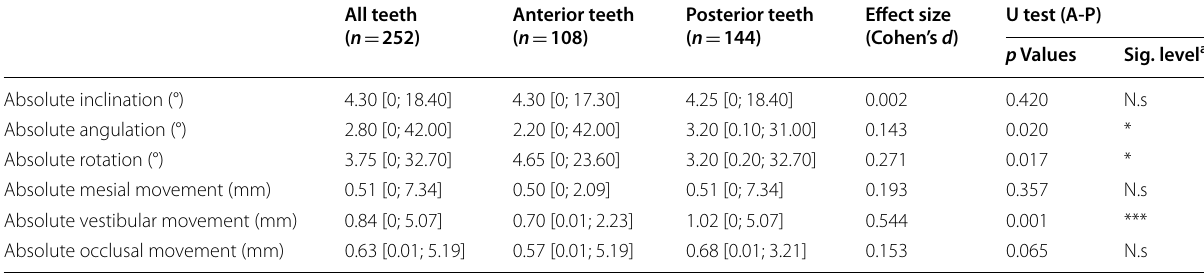
Absolute values of discrepancies (median [min; max]) of the dental arch for all teeth and for both frontal and posterior teeth separately and their effect size (Cohen’s d ) were reported. Given are inclination, angulation, rotation, mesial (sagittal) position, vestibular (transversal) position and occlusal (vertical) position. Mann–Whitney U test was applied to compare anterior and posterior teeth